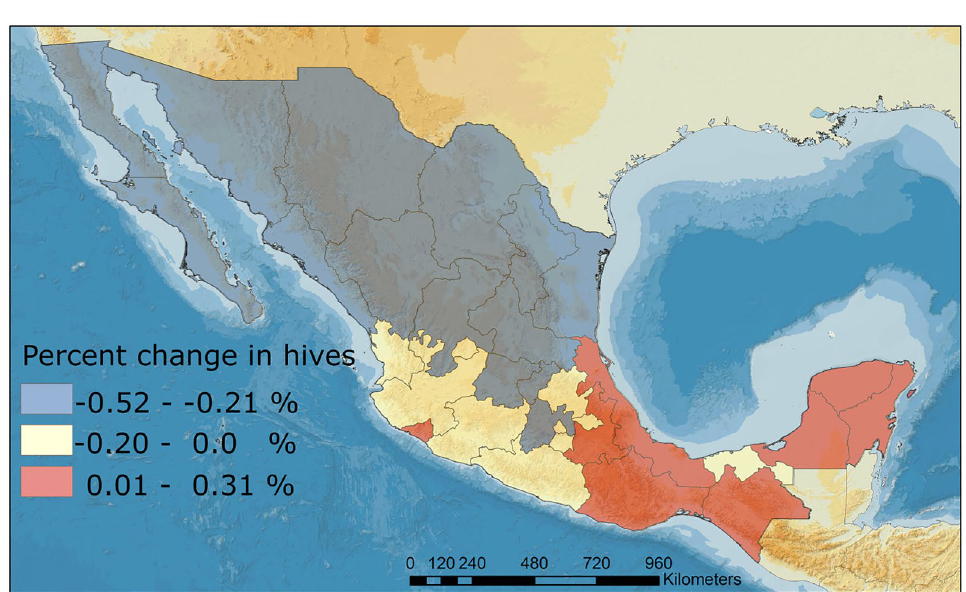
Figure 3. Predicted spatial patterns from the GAMM model for the percent change in honey bee hives between 1980 and 2012 across